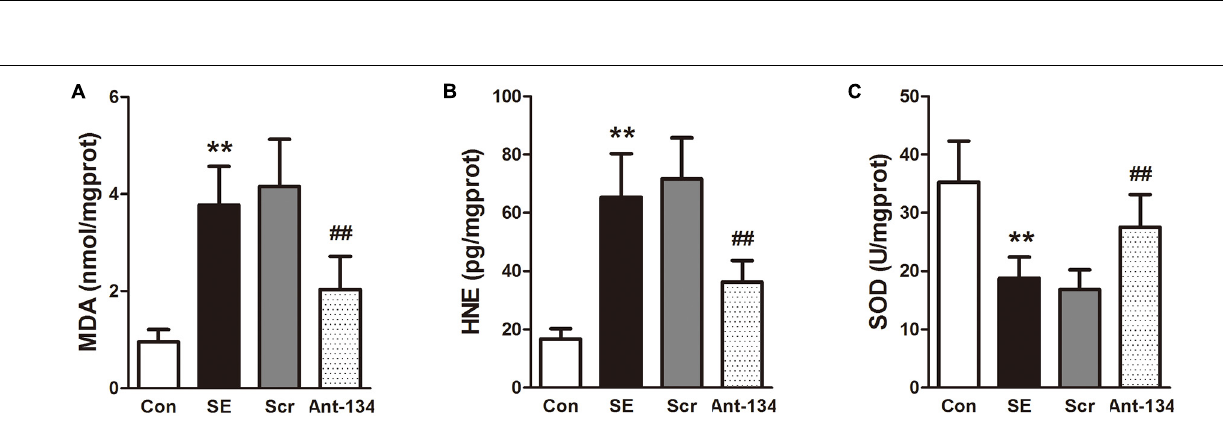
FIGURE 3 | Silencing miR-134 attenuated neuronal death in hippocampus of SE rats. (A) Nissl staining of hippocampal neurons. (B) Quantification of Nissl body number. (C) TUNEL staining of hippocampal sections. (D) Quantification of TUNEL-positive cells. Scale bar: 100 µ m in A and 50 µ m in (C) . Data are expressed as mean ± SD, n = 6. ∗∗ p < 0.01, versus the control group, ## p < 0.01, versus the SE group.